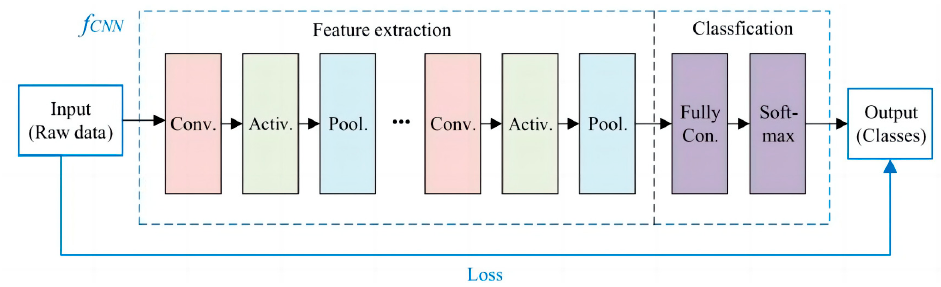
Figure 13. The framework of the CNN-based model in 2022. Reprinted with permission from Ref.